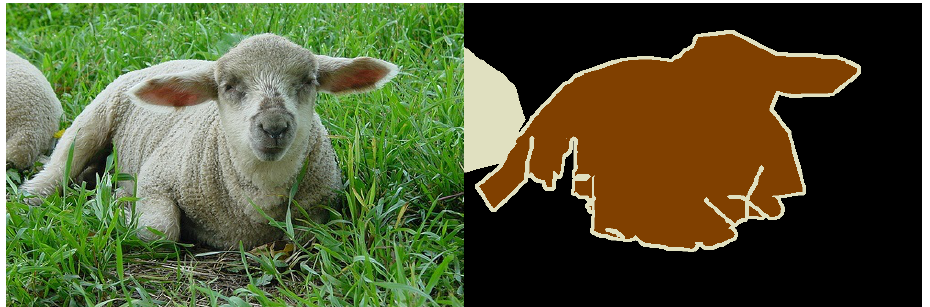
Figure 1. An example of semantic image segmentation taken from the Pascal Visual Object Class dataset. The image on the right is a mask, where each pixel is numbered according to the image